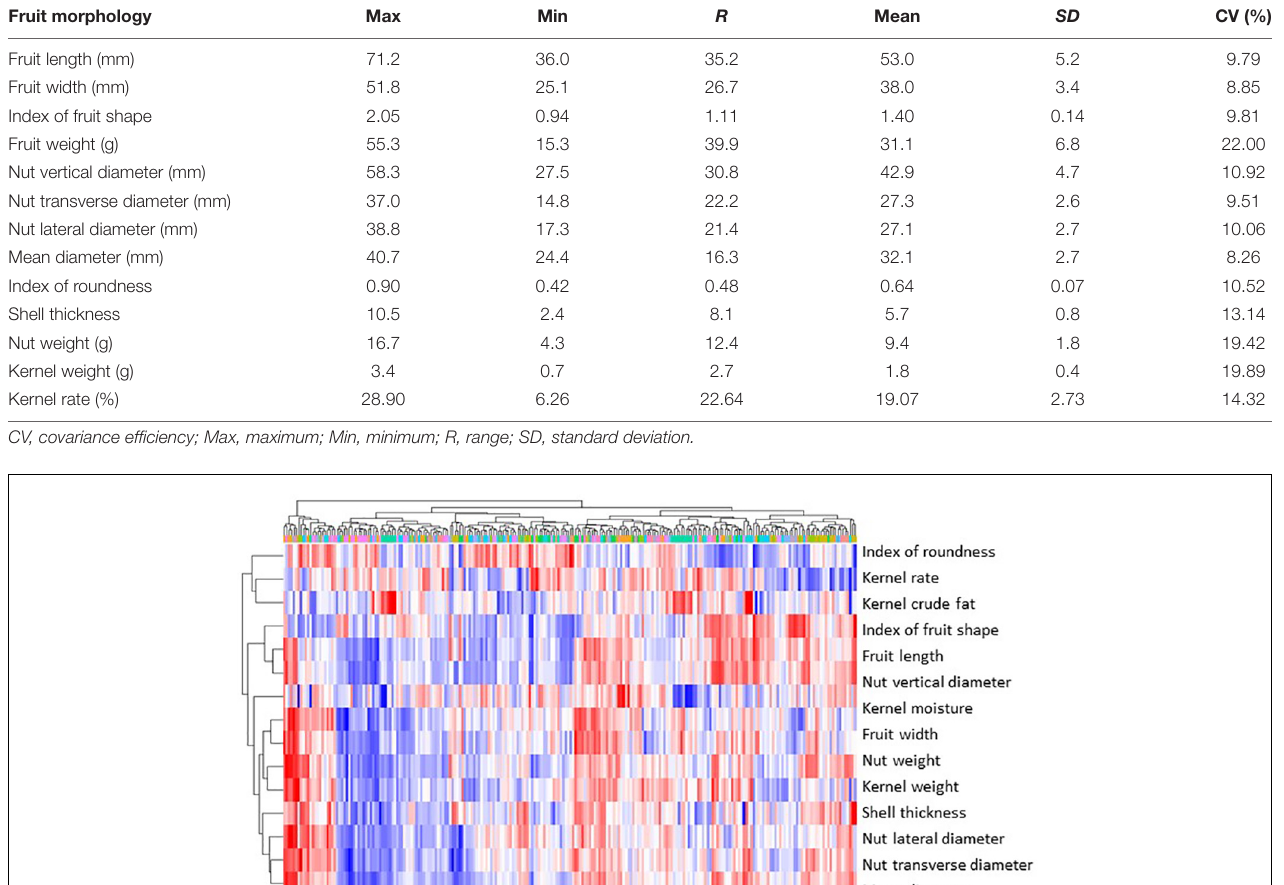
based on the relative range (large to small): group 1 (BX, DFH, SC, and TL), group 2 (WC, DJC, YBL, HL, LJ, and JY6), and group 3 (JST and